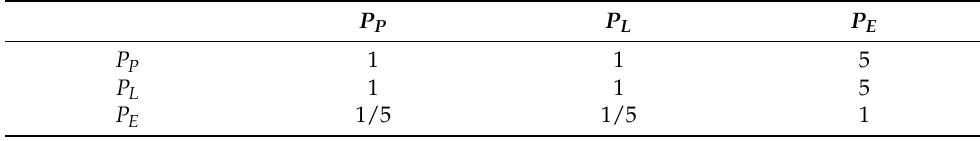
Table 8. Judgment matrix in the category layer.